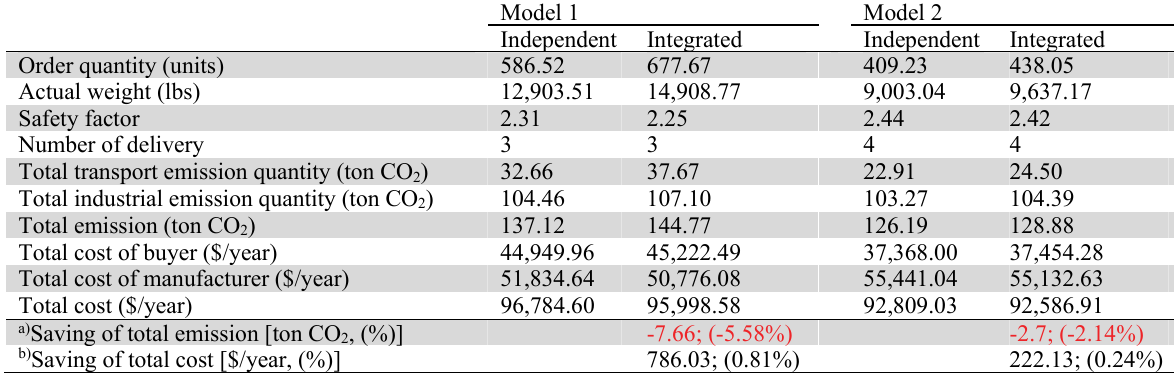
The comparison of independent and integrated policies for model 1 and model